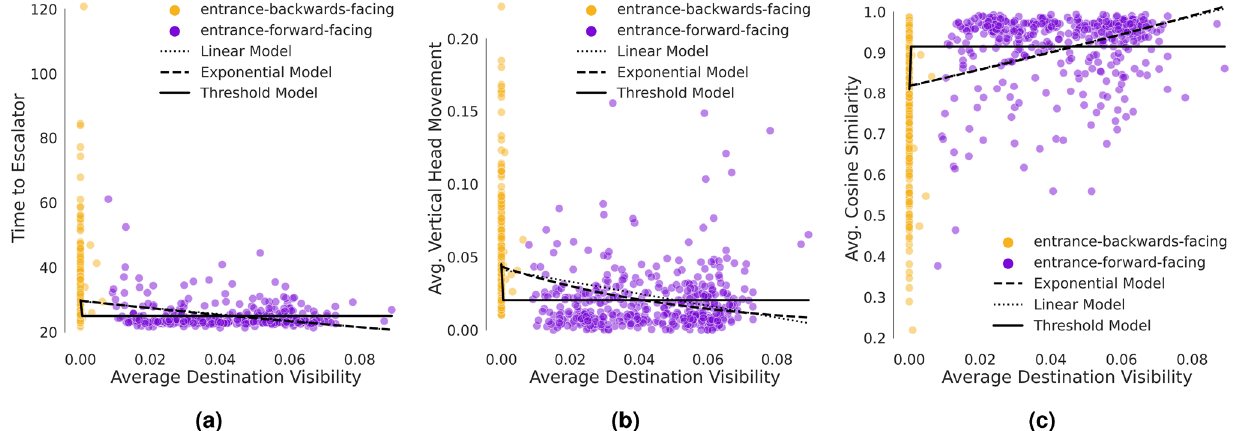
Figure 2. The raw data and fitted models showing the relationship between ‘ Average Destination Visibility ’ and behavioral wayfinding measures, ( a ) ‘ Time to Escalator ’ , ( b ) ‘ Average Vertical Head Movement ’ , ( c ) ‘ Average Cosine Similarity ’ between participants ’ heading and the vector pointing towards the escalator. Software used to create these figures: Python 34 (version 3.5.8), https:// www. python. org/ downl oads/ relea se/ python- 358/; Seaborn 35 (version 0.11.1), https:// seabo rn. pydata. org/ index. html; Matplotlib 36 (version 3.3.2), https:// matpl otlib. org/3. 3.2/ users/ insta lling.